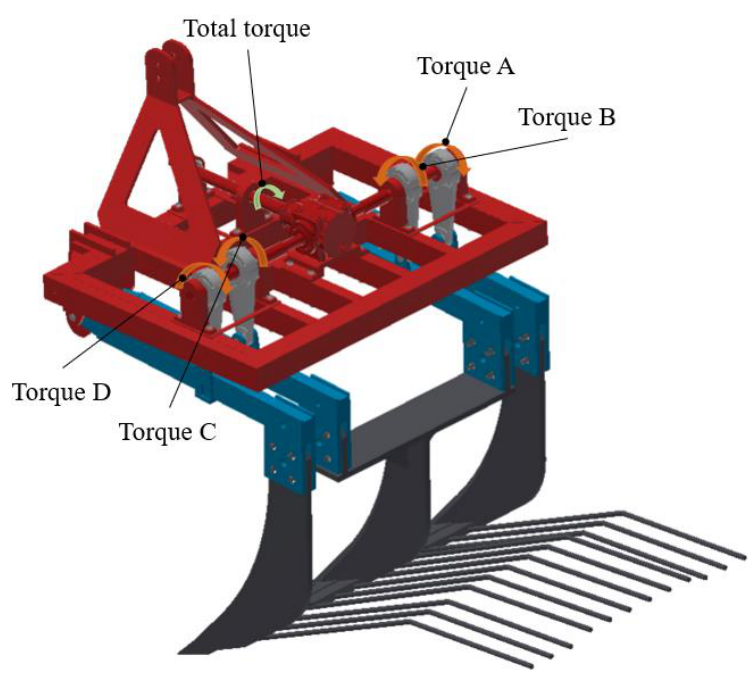
Figure 4. Diagram of total torque and excitation device torque.